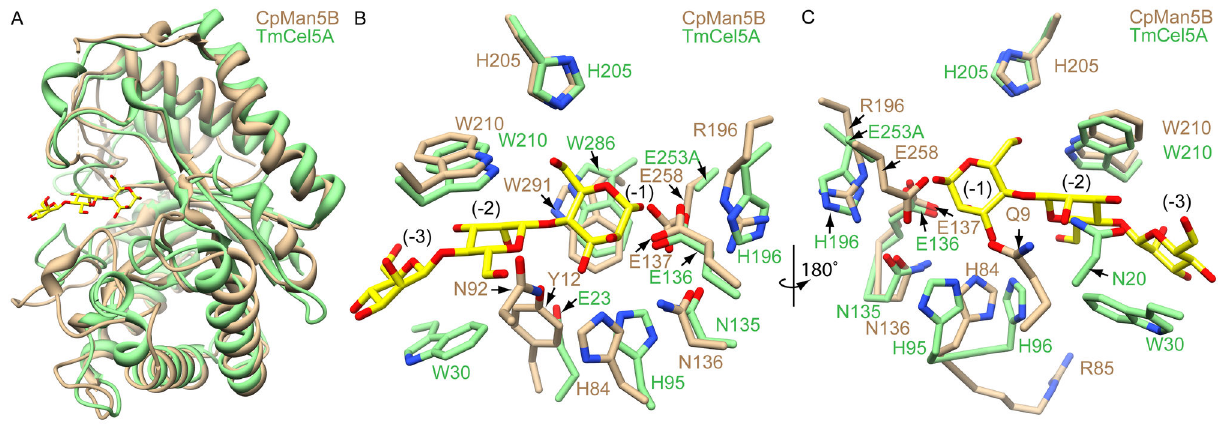
Figure 3. Structural comparison of CpMan5B with Thermotoga maritima cellulase (TmCel5A). A, The TmCel5A-mannotriose complex (green, PDB ID: 3AZS) is superimposed onto CpMan5B (tan). B, Close-up view of the active site. The mannotriose molecule bound to TmCel5A is shown by a stick model colored yellow and red for carbon and oxygen atoms, respectively. Contacting residues of TmCel5A (green), and the corresponding residues of CpMan5B (tan) are shown in panel B. Sugar subsites are indicated in black font. C. The active site has been rotated 180° around the y-axis relative to the view in panel B. doi: